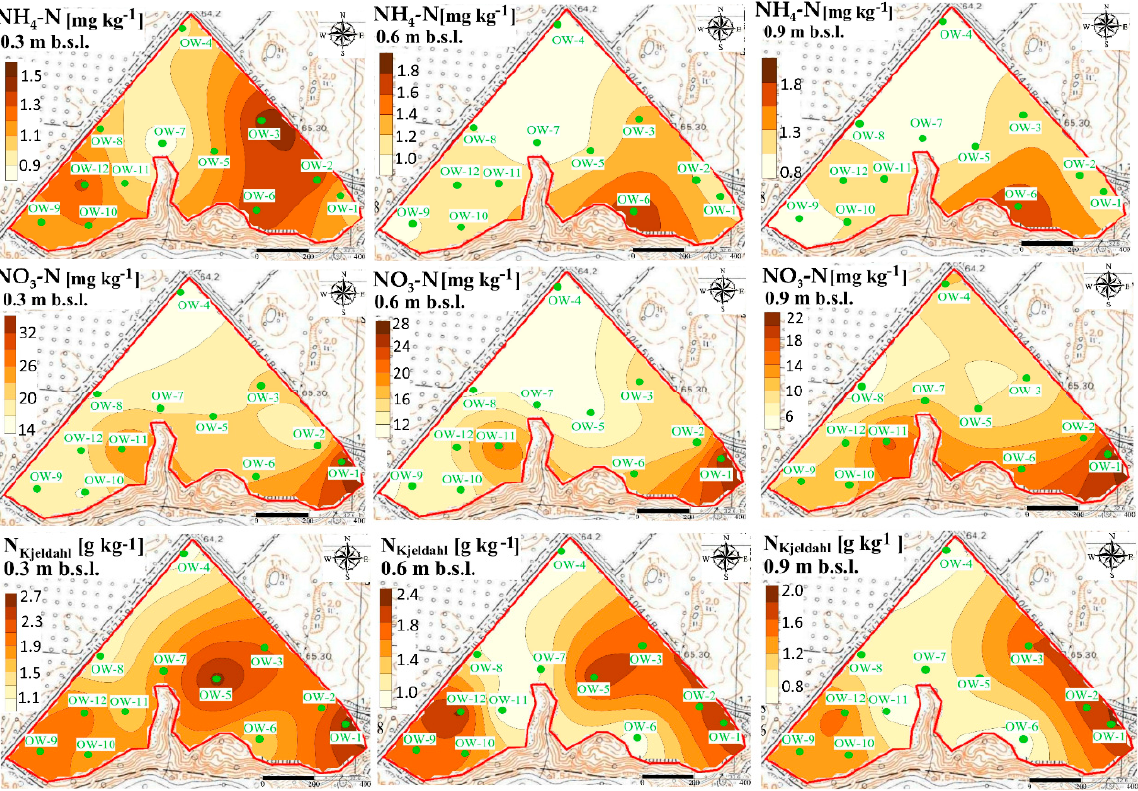
Figure 10. Spatial distribution of ammonium, nitrate, and N Kjeldahl in soil at the B experimental site after UNI fertilization.